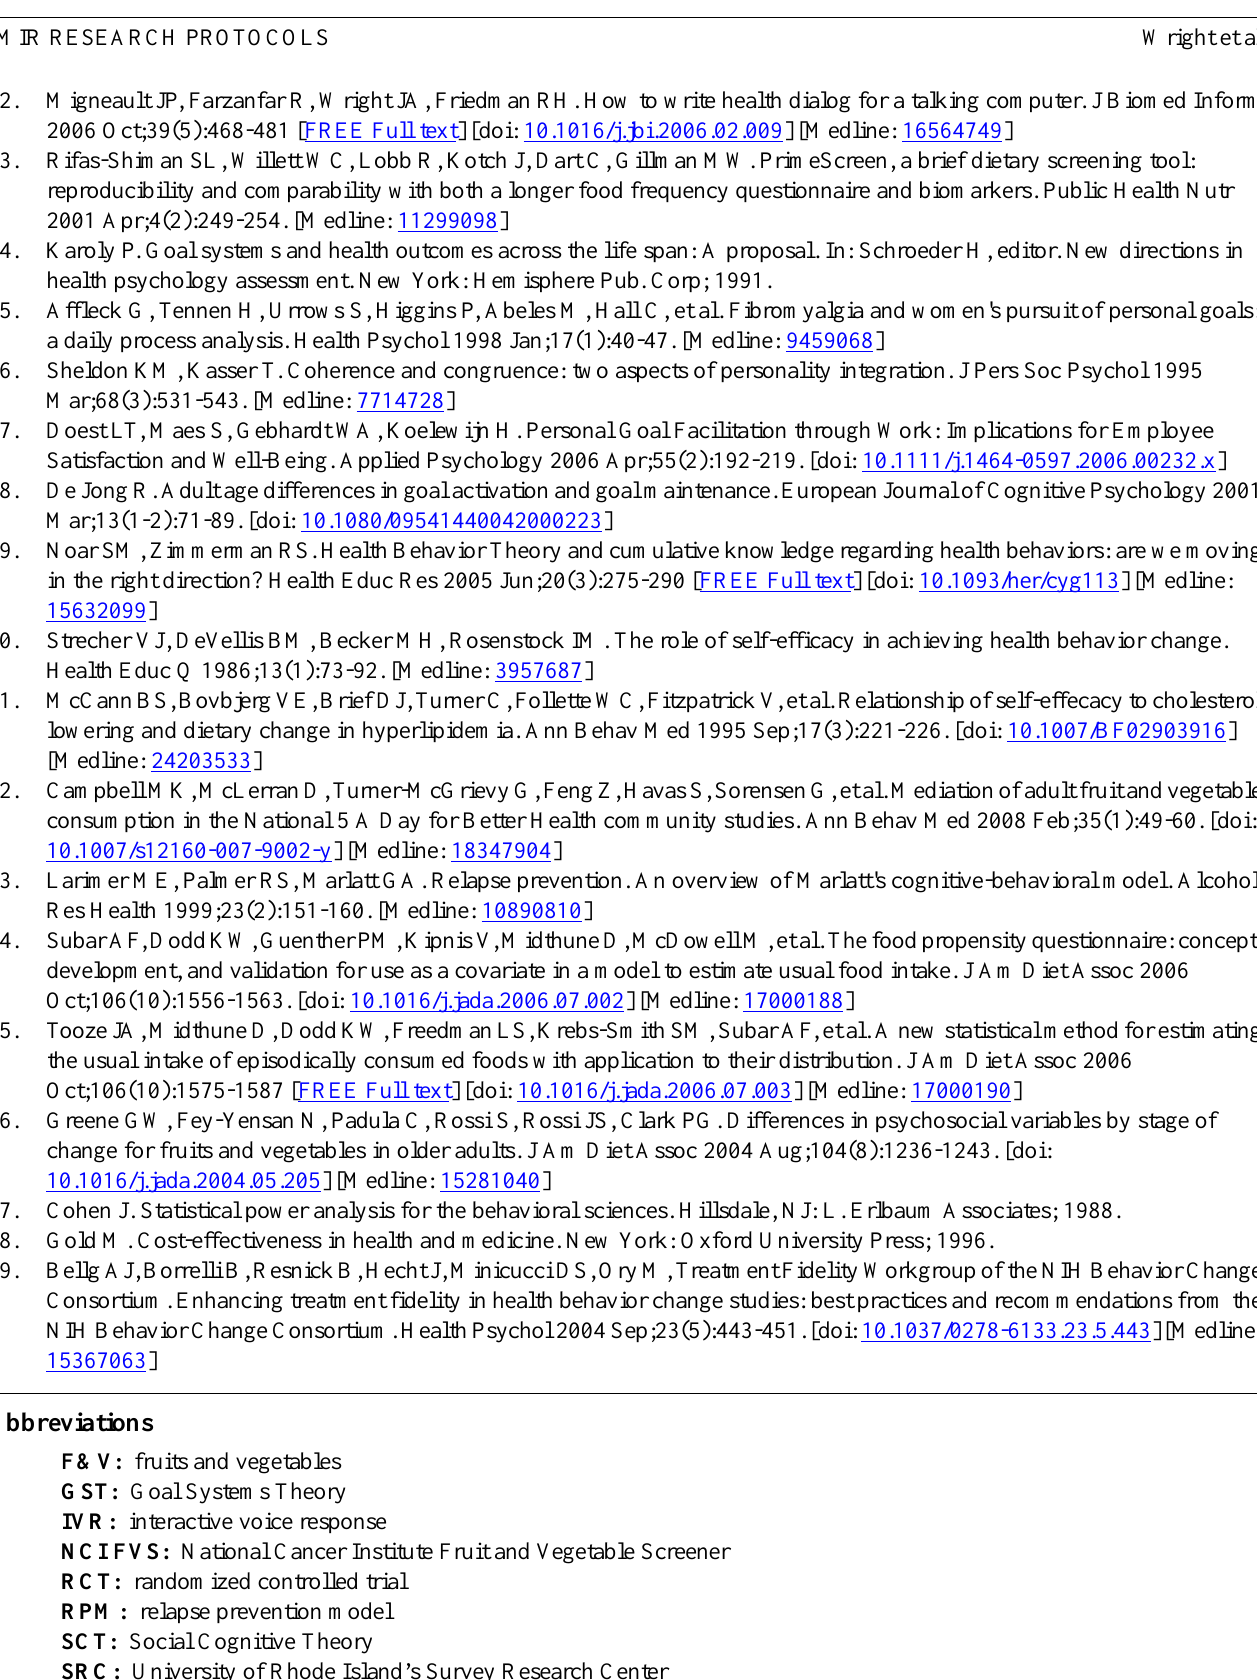
TLC-EAT: telephone-linked care delivered dietary acquisition intervention TLC-GST: telephone-linked care delivered dietary maintenance intervention based on Goal Systems Theory TLC-SCT: telephone-linked care delivered dietary maintenance intervention based on Social Cognitive